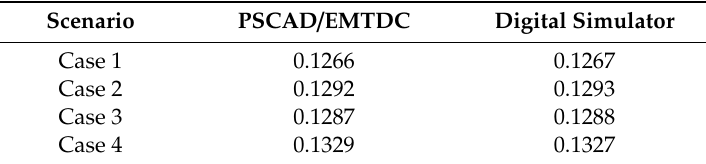
Figure 13. Simulation results using PSCAD/EMTDC: ( a ) Case 1; ( b ) Case 2; ( c ) Case 3; and ( d ) Case 4. Table 6. Simulation results − relay operation time(s).